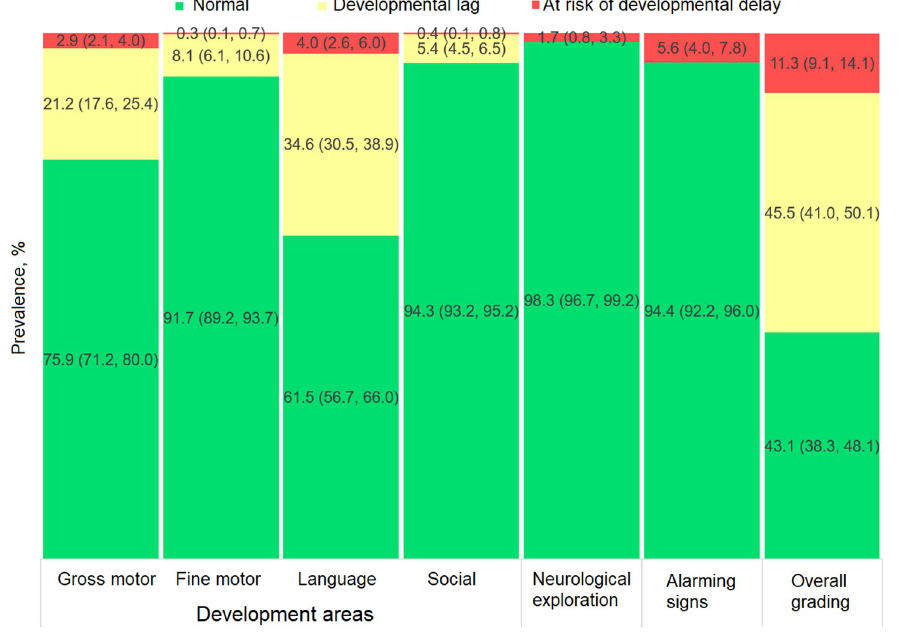
Fig 2. Prevalence of child development categories from the EDI-II test (n = 1,131).